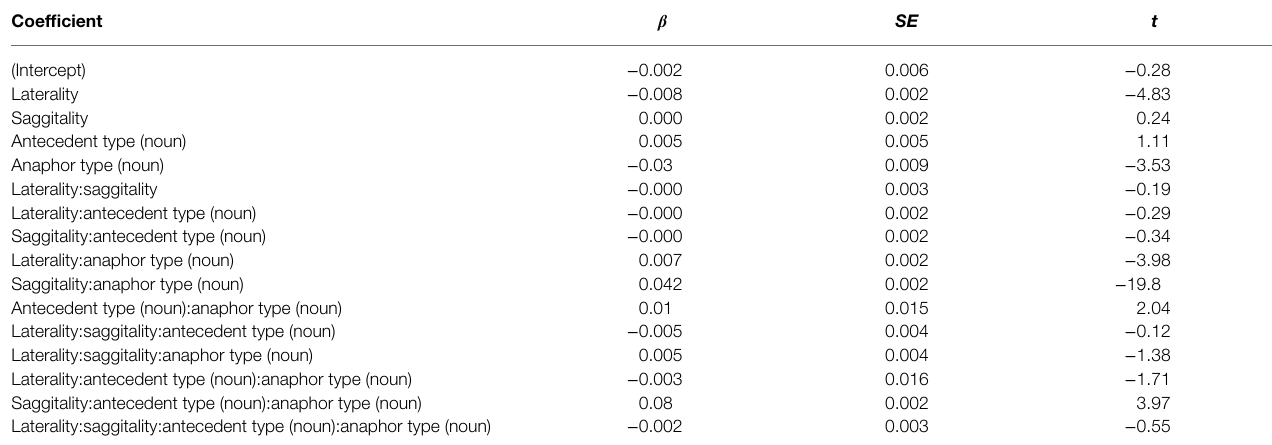
TABLE 4 | Summary of the statistical model of the N400 time window.